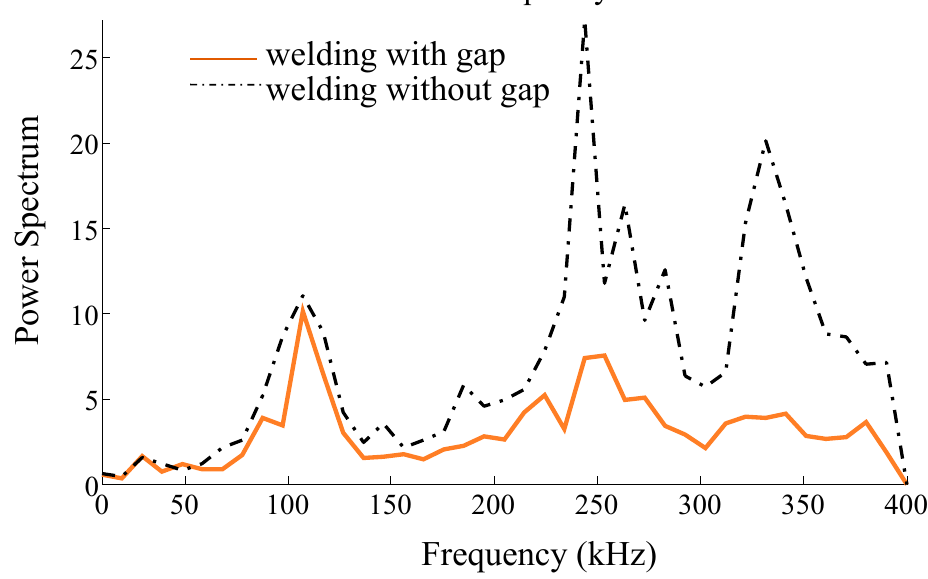
Figure 7. Frequency AE signals collected during laser microwelding for normal (without gap) and low bonding strength (with gap).